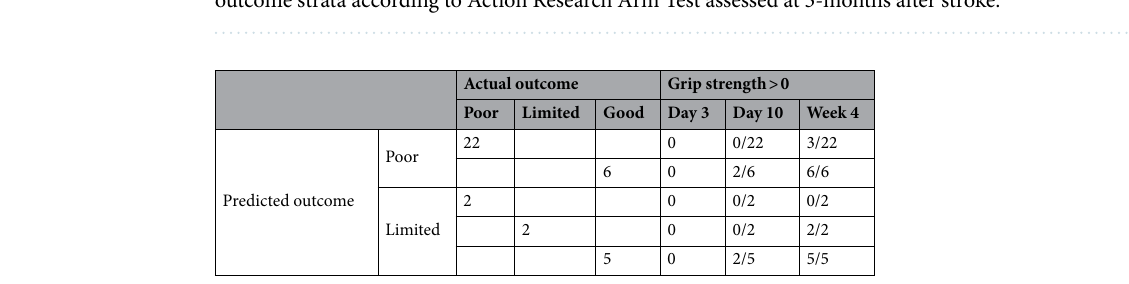
Table 4. Grip strength measured at 10-days and 4-weeks post stroke shown in patients with poor or limited predicted functional outcome. Values indicate frequencies (n).